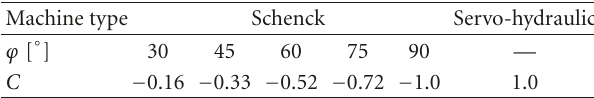
Table 2: Biaxial stress ratio obtained by a strain gauge